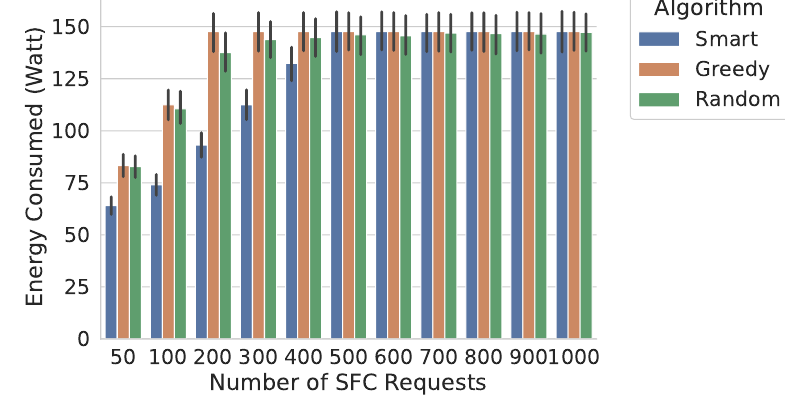
Figure 8. Consumed energy in edge